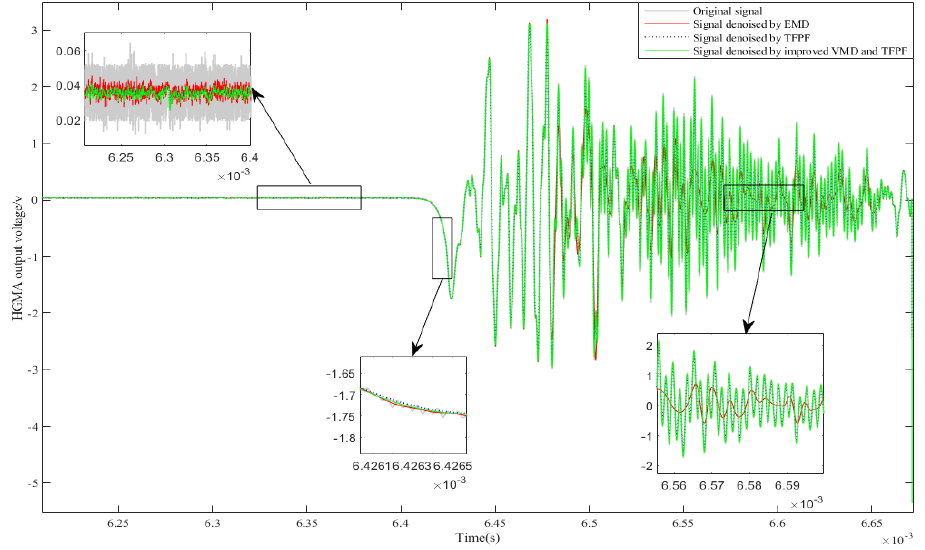
Figure 17. The denoising results of HGMA output signal. For the static phase: The signal in the static stage contains abundant noise, and the peak-to-peak value is about 0.054 V. From the denoising results, it can be seen that these denoising methods all have good denoising effect. However, compared with EMD, the improved VMD-TFPF and TFPF denoising algorithms have stronger denoising abilities. After denoising with the improved VMD-TFPF algorithm, the peak-to-peak value of the signal is reduced to about 0.006